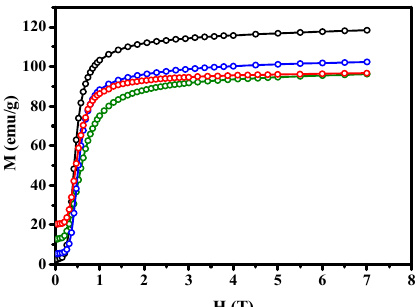
Figure 4. Magnetization traces at 5K of Er(Fe 0.2 Mn 0.8 ) 2 (black), Er(Fe 0.8 Mn 0.1 Co 0.1 ) 2 (green), Er(Fe 0.7 Mn 0.2 Co 0.1 ) 2 (blue), and Er(Fe 0.7 Mn 0.1 Co 0.2 ) 2 (red) upon increasing the applied field up to 7 T.